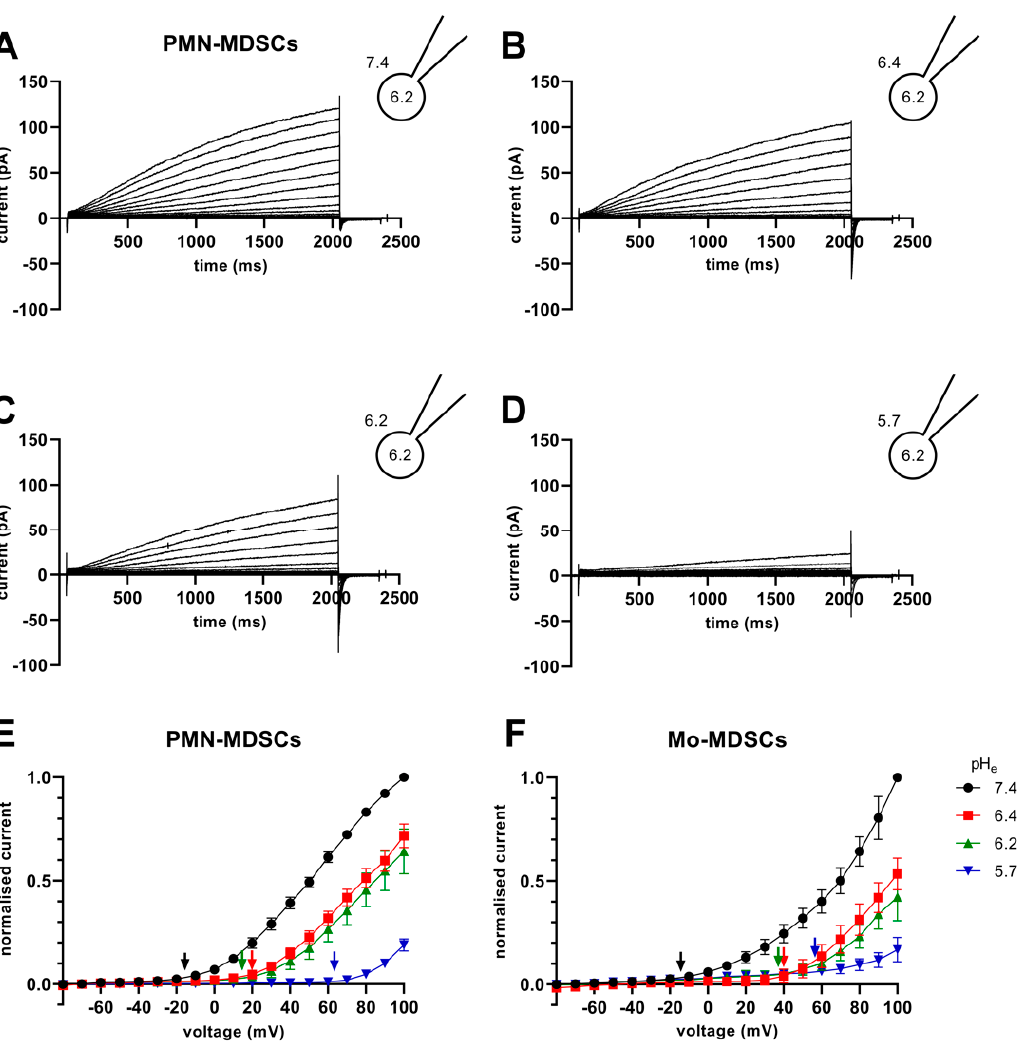
Figure 8. Families of H + currents and I-V curves in murine PMN- and Mo-MDSCs. ( A – D ) Representative family of whole-cell H + currents in murine PMN-MDSCs isolated freshly from LLC. Depolarizing 2 s long pulses were applied from a holding potential of − 80 mV to +100 mV in 10 mV increments. While the internal solution was maintained constantly in the micropipette at pH i 6.2, the cell was locally perfused at different pH e (7.4 ( A ), 6.4 ( B ), 6.2 ( C ) and 5.7 ( D )). Representative of 11 ( A ), 8 ( B ), 4 ( C ) and 3 ( D ) similar families of currents. Every trace has been filtered with a 25-point boxcar filter. ( E , F ) I–V curves for PMN- ( E ) and Mo-MDSCs ( F ) were built using the peak currents of every trace in every condition (black: pH e 7.4; red: 6.4; green: 6.2; blue: 5.7) normalized to their respective current at +100 mV/pH e = 7.4. The V thr for every pH e condition was calculated (see Materials and Methods, data analysis) and subsequently pointed out in the plot using an arrow with the associated color. Every value with its error bar indicates the mean ± SEM (( E )–7.4: n = 10–11, 6.4: n = 7–8, 6.2: n = 4, 5.7: n = 3. ( F )–7.4: n = 5–9, 6.4: n = 4, 6.2: n = 2–4, 5.7: n = 4–5).